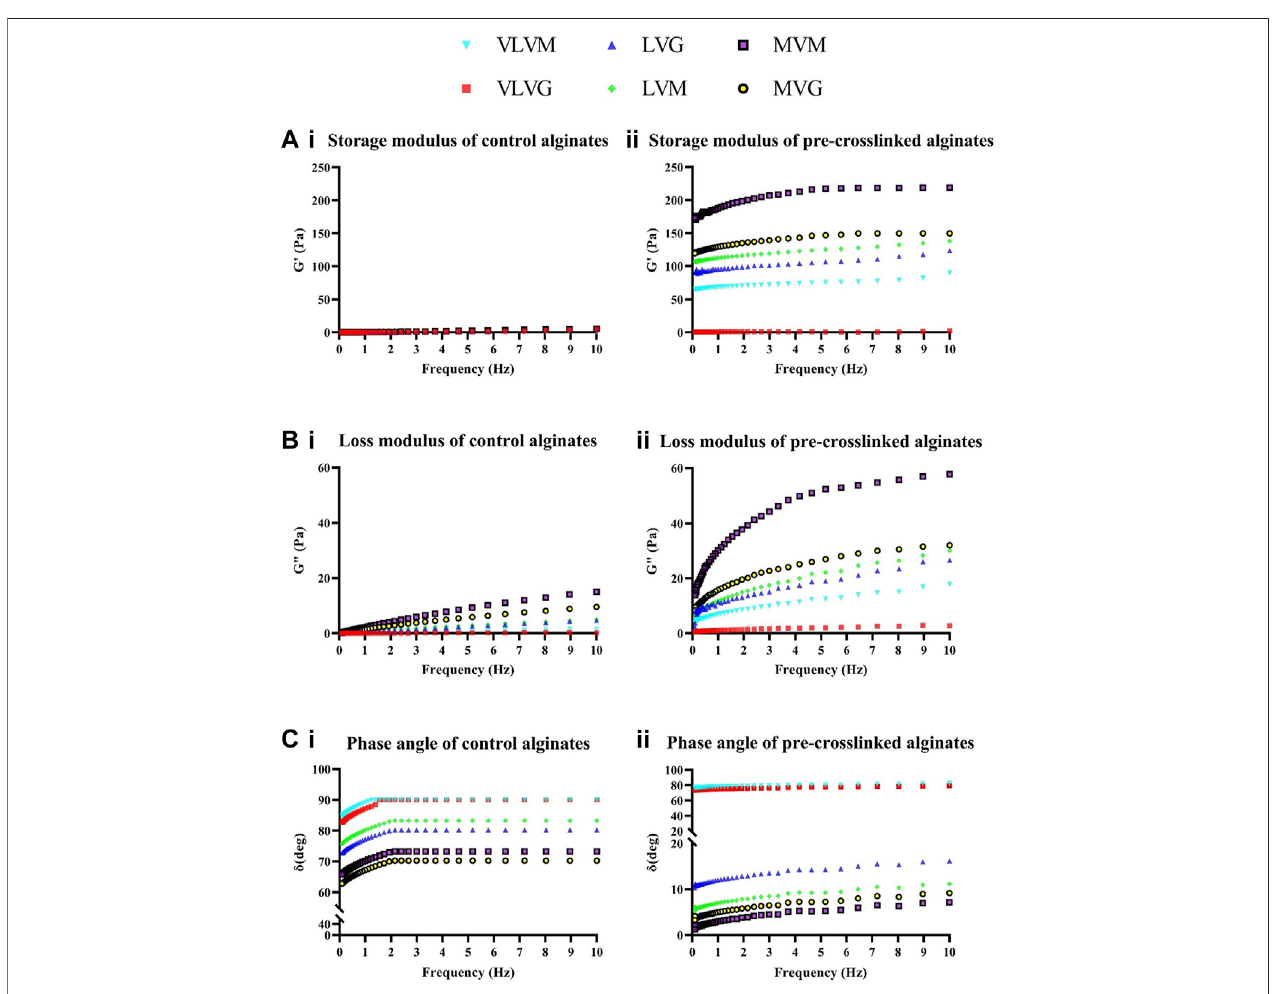
FIGURE4| Shearrheologicalassessment.Assessmentofrheologicalparametersofcontrolandpre-crosslinkedalginatebio-inkswasperformedusingarotational rheometer. Storage moduli of control (Ai) and pre-crosslinked (Aii) alginates, loss moduli of control (Bi) and pre-crosslinked (Bii) alginates and phase angle of control (Ci) and pre-crosslinked (Cii) alginates were measured. Values are expressed as means from six separate experiments.